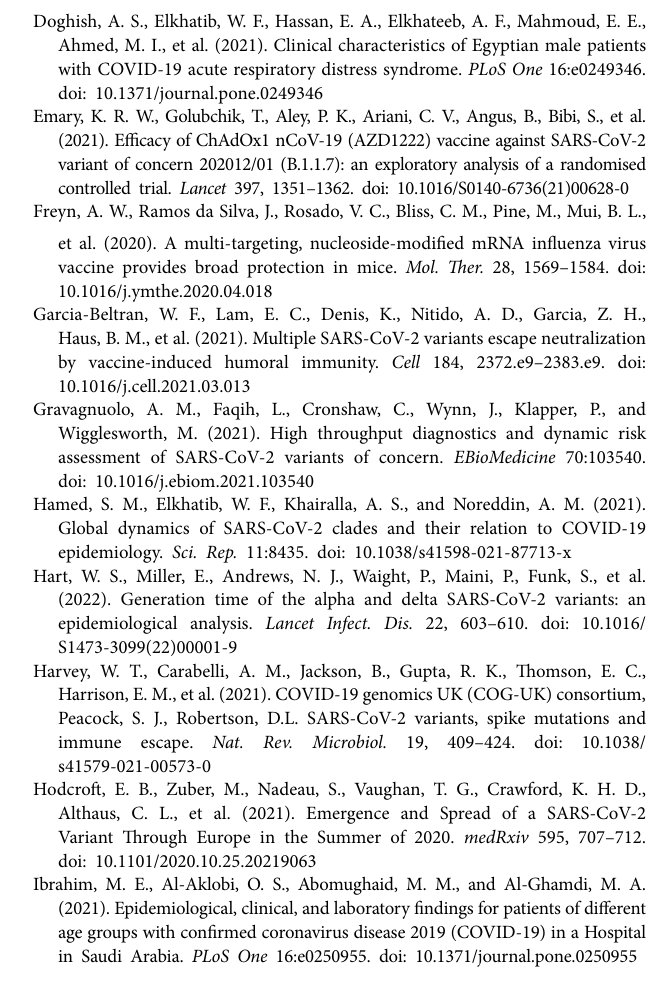
Supplementary Table S1 | The data of sequences under